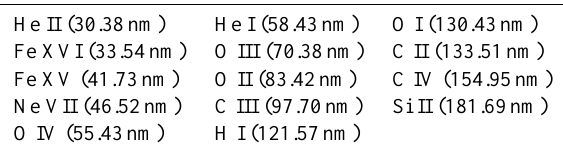
Table 1. The 14 lines that are adequate for reconstructing the solar EUV spectrum from 26 to 194nm.